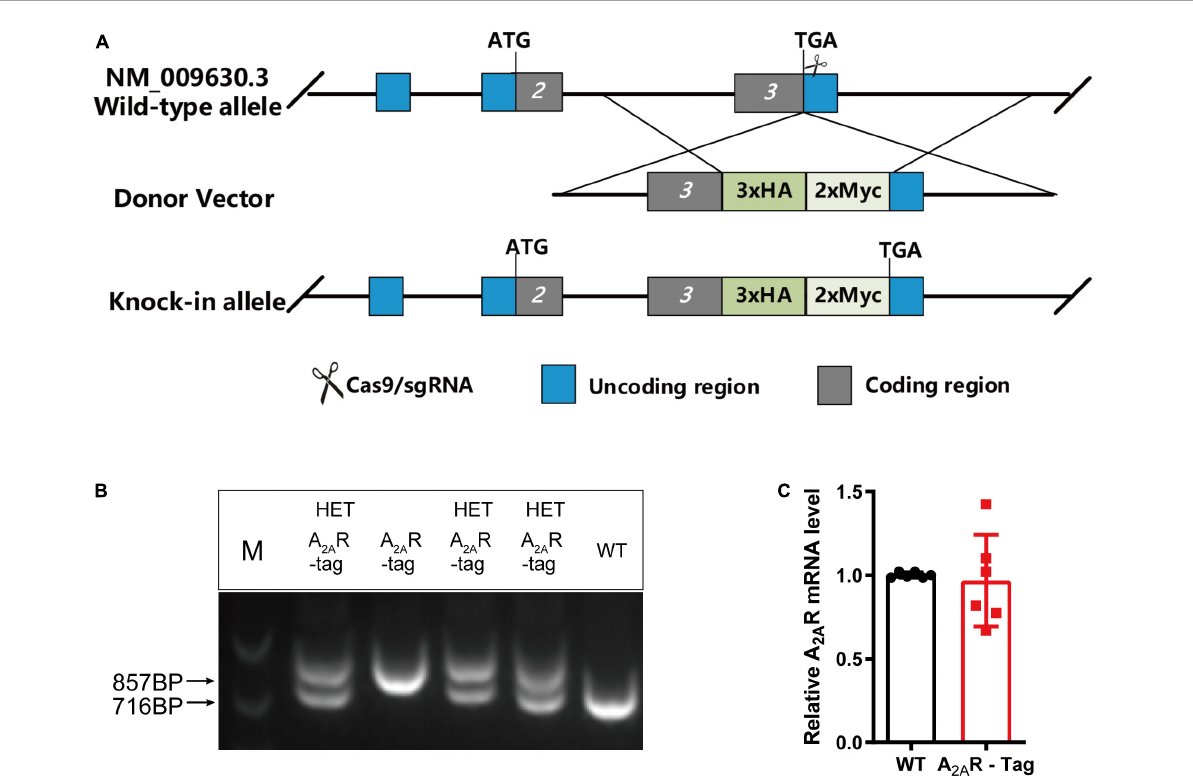
FIGURE1 Knock-in construct, genotyping scheme, and adenosine A 2 A receptor (A 2A R) mRNA levels in A 2A R-tag mice. (A) Targeting strategy. (B) PCR analysis of gene editing in A 2A R-tag mice. Using tail genomic DNA, the 857-bp PCR product was only detected in A 2A R-tag homozygous mice and the 716-bp product only in wild-type littermates, otherwise, two fragments (716-bp and 857-bp) from A 2A R-tag heterozygous mice were detected. (C) The mRNA levels were determined by performing RT-PCR using striatum from A 2A R-tag heterozygous mice, as described in “Materials and methods” section. N = 6 mice of each genotype. Data are mean ± SEM (each dot represents one mouse, Mann–Whitney U